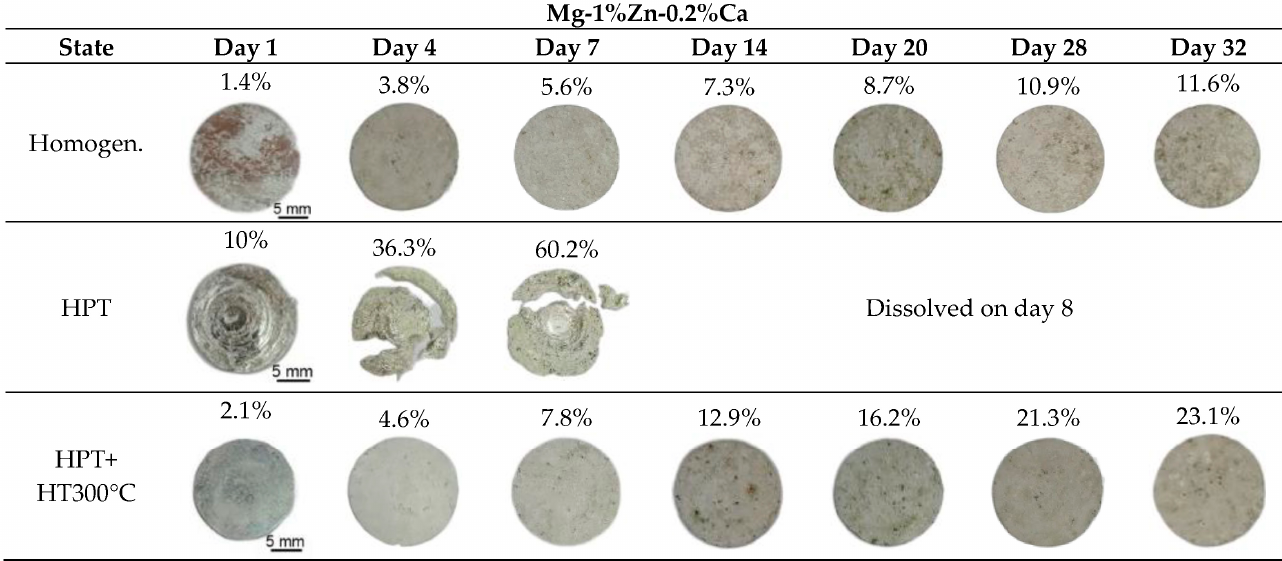
Figure 1. View of the Mg ‐ 1%Zn ‐ 0.2%Ca alloy samples (diameter 20 mm) in the homogenized state, after high ‐ pressure torsion (HPT) and after HPT and heat treatment (HT) at 300 °C during corrosion tests in Ringer’s solution; the exposure time of the samples was from 1 to 32 days (optical photographs). Table 1. Mass loss and corrosion rate of the Mg ‐ 1Zn ‐ 0.2Ca alloy during corrosion tests in Ringer’s solution.